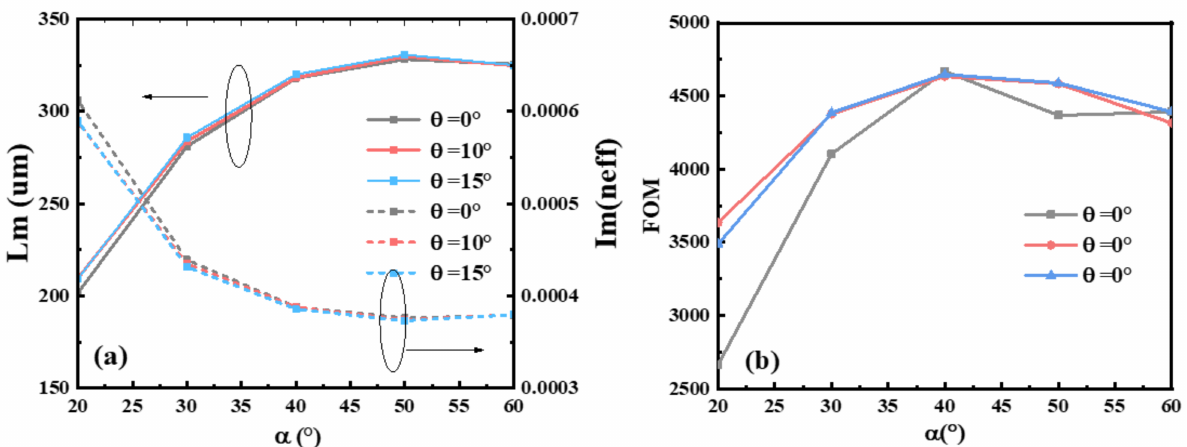
Figure 5. Relationship between mode properties and vertex angle with different rotation angles: ( a ) propagation length L m and the imaginary part of modal effective refractive index (cid:16) (cid:17) Im n ef f ; ( b ) the figure of merit FOM . Here, r = 45 nm, h = 13 nm, rw = 0.